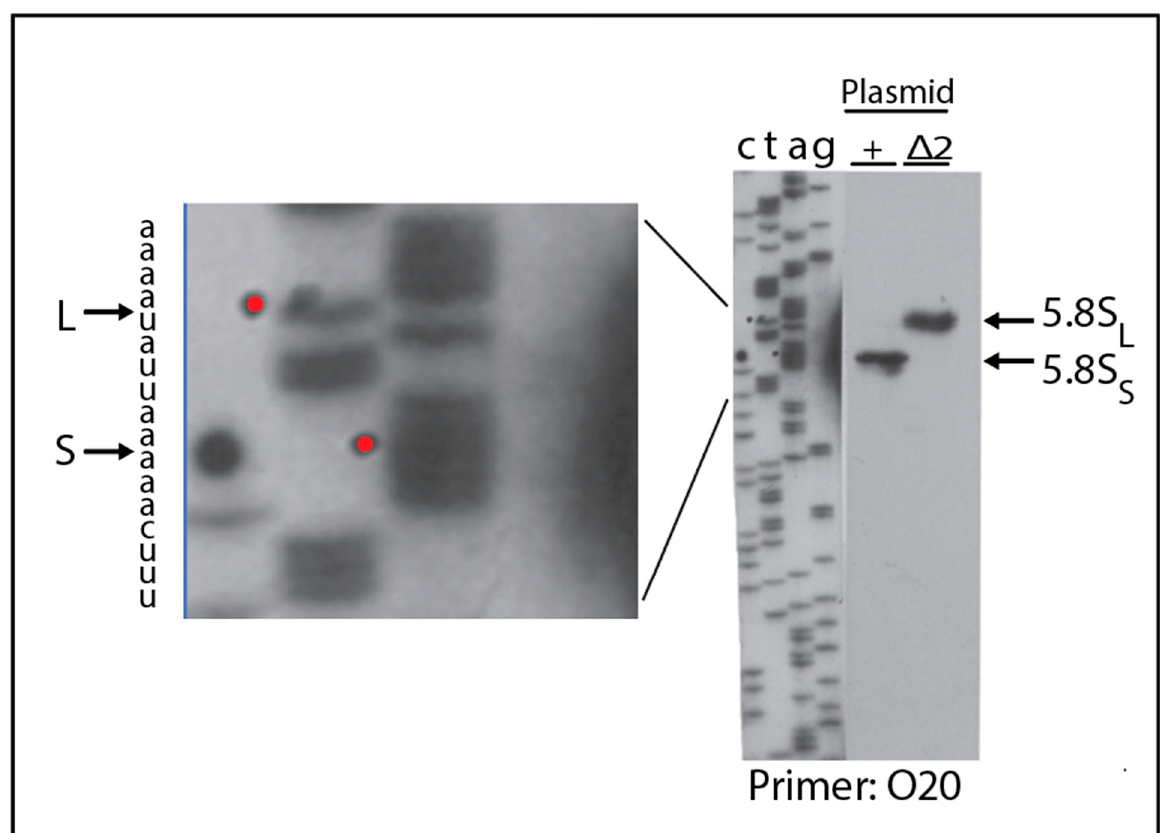
Figure 4. Mapping of 5 ′ ends of 5.8S rRNA processed from ∆ 2 and wildtype rRNA genes carried on plasmid pDK16. The host strain ∆ rpa135 carrying wildtype pDK16 or pDK16 ∆ 2 was grown in steady state at 30°. Total RNA was isolated and used for extension of primer O20. Di-deoxy sequencing ladders generated by extension of the O20 primer on the pDK16 DNA are shown as markers. Red dots in the sequence lanes indicate the bands that line up with the primer extension products. Note that the gel was loaded using a “shark-tooth comb”, meaning that there is minimal space between the slots. The primer extension products from the pDK16 and pDK16 ∆ 2 were each loaded twice in neighboring lanes, but since the lanes are close, the bands of the duplicate loadings virtually merged into a single double-width band. Furthermore, a few irrelevant lanes between the sequence ladder and the primer extension products were excised from the image.